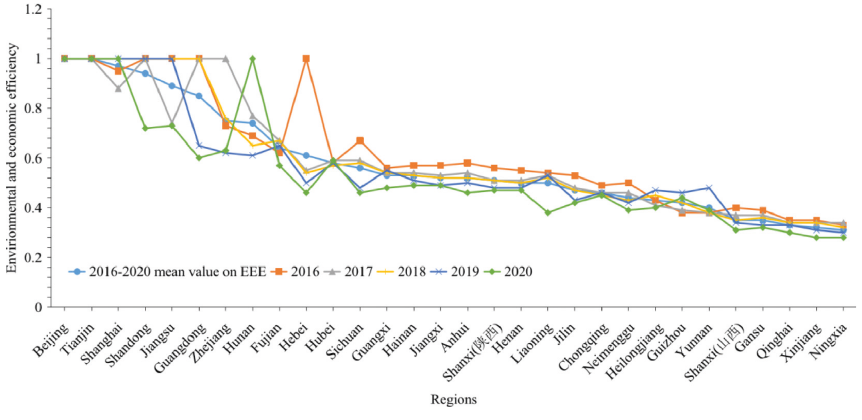
Figure 11: EEE value in different